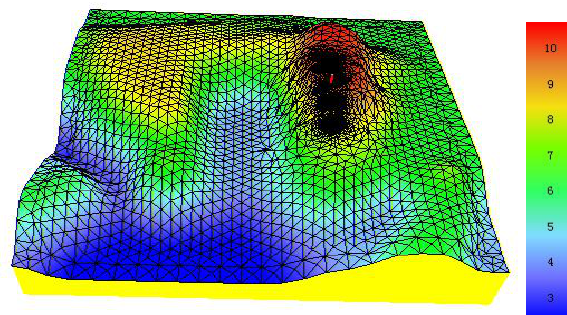
Figure 7—Distribution of effective thickness around SuA-B-CH2